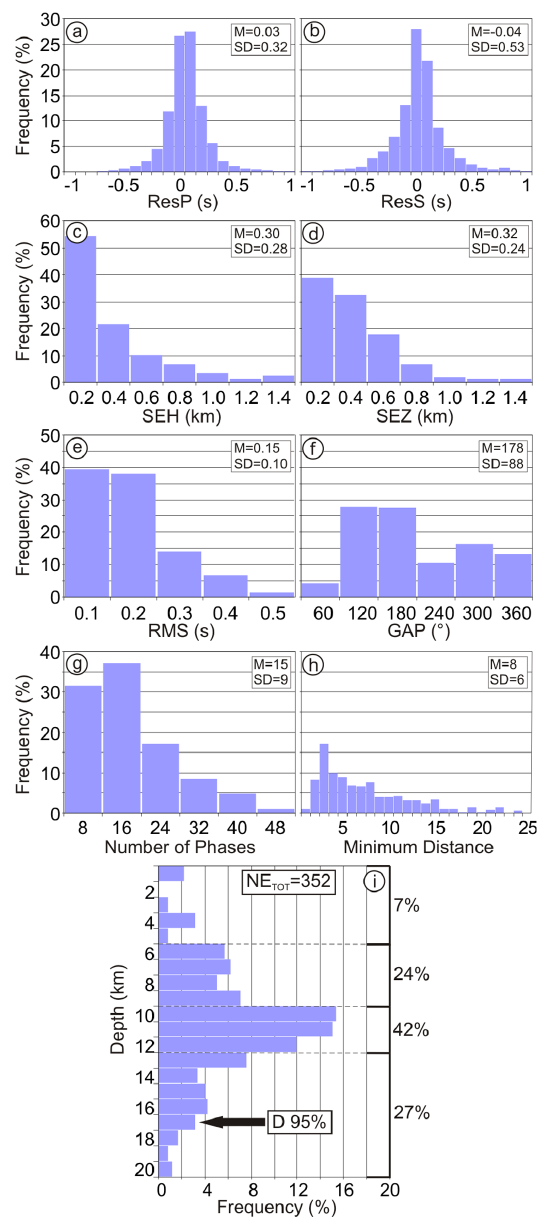
Fig. 8. Features of quality A earthquake locations. (a, b) Histograms of residuals of P and S phases (ResP, ResS). (c, d) Horizontal and vertical formal errors (SEH, SEZ). (e, f) Root mean square of travel- time residuals (RMS) and GAP distribution. (g, h) Number of used phases and minimum hypocentre to station distance. From (a) to (h) , in the upper-right corners, the mean (M) and standard devia- tion (SD) of distributions are reported. (i) Depth distribution of the hypocentres. The black arrow identifies the seismogenic layer cor- responding to 95% of the hypocentral distribution. On the right side the percentages of the events occurred in the depth intervals 0–5km, 5–9km, 9–12km, 12–17km and deeper are reported. Also, the total number (NE TOT ) of quality A events is